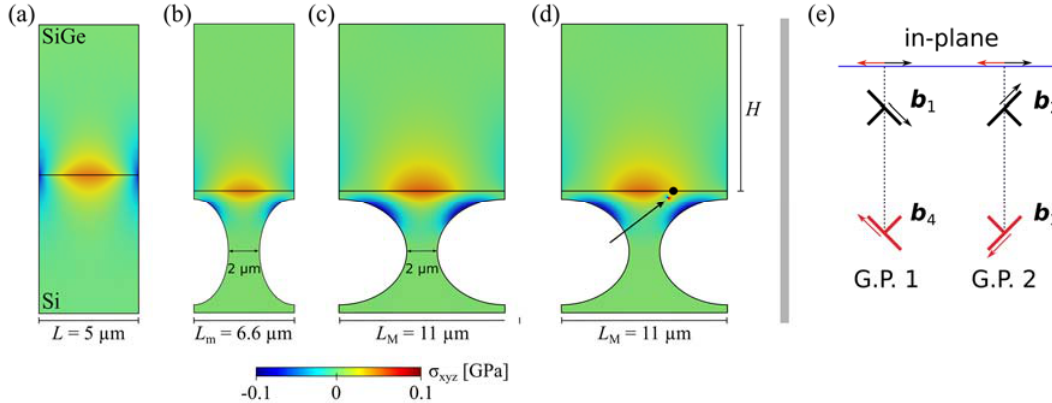
Figure 12. Model results. Hydrostatic stress maps ( σ xyz) and considered geometry for the vertical ( a ) and under-etched ( b ), ( c ) Si pillars. The SiGe/Si interface is marked with a black line. Two considered pillar bases L m ( b ) and L M ( c ) are taken to mimic the extreme values of bases measured on the tapered geometry of the grown pillar (Figure 9c). In ( d ) is reported the stress map for an under-etched pillar once the first dislocation is introduced. In panel ( e ) a schematic representation of the four possible Burgers vectors is reported along with their in-plane projection. Reproduced with permission from [46]. American Physical Society.